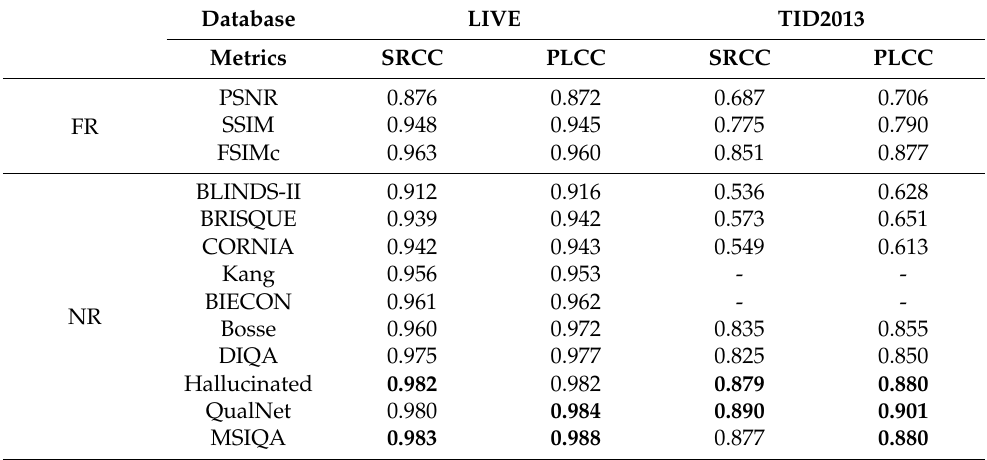
Table 4. Comparison of the SRCC and PLCC with different methods on LIVE and TID2013 database.